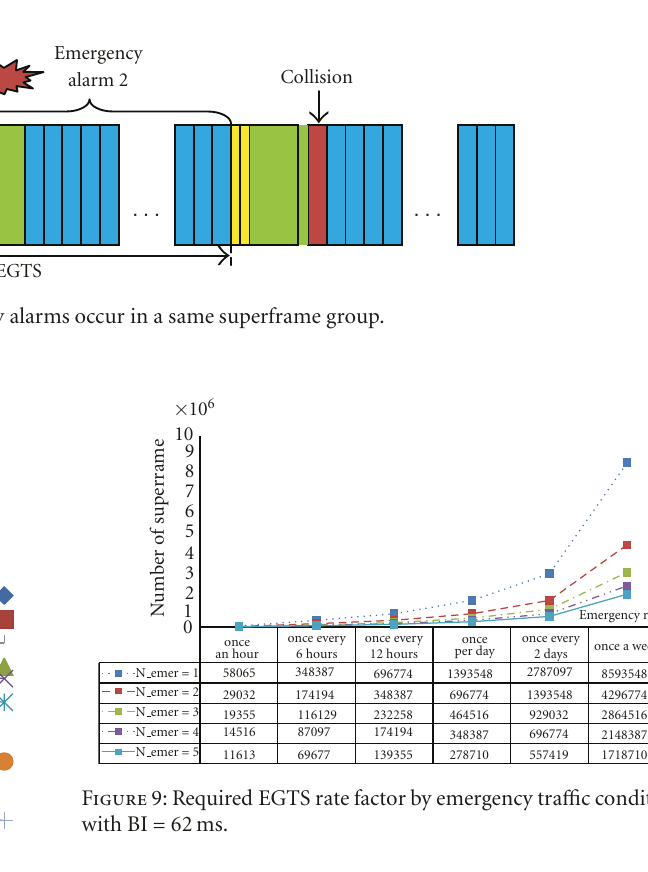
Figure 6: Multiple emergency alarms occur in a same superframe with EGTS.